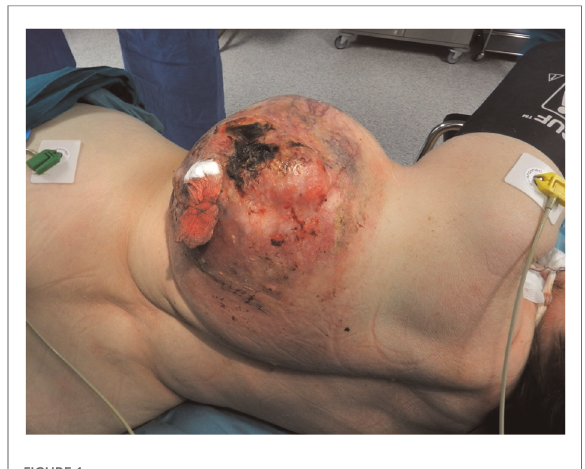
FIGURE 1 The bleeding necrotic tumor mass on the left posterolateral surface of the